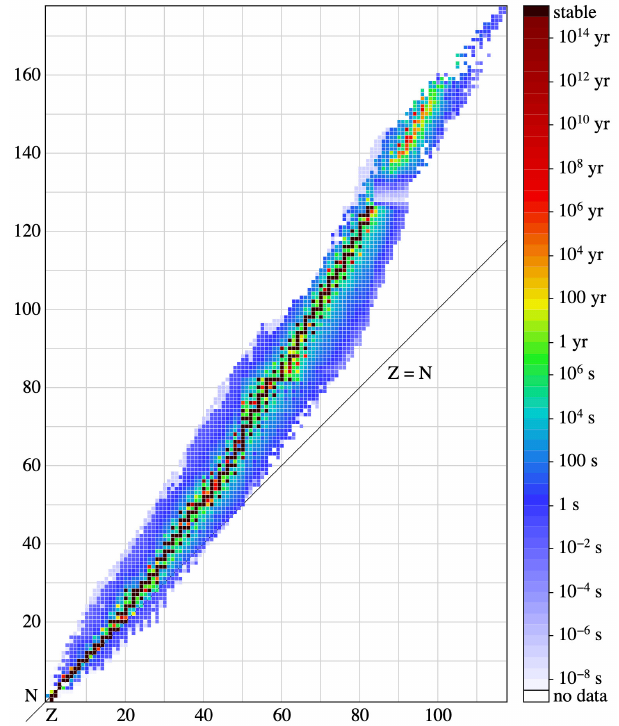
Figure 8. Half-lives of isotopes (Z: number of protons, N: number of neutrons). Data from National Nuclear Data Center (NuDat2 database 6/1/2012)